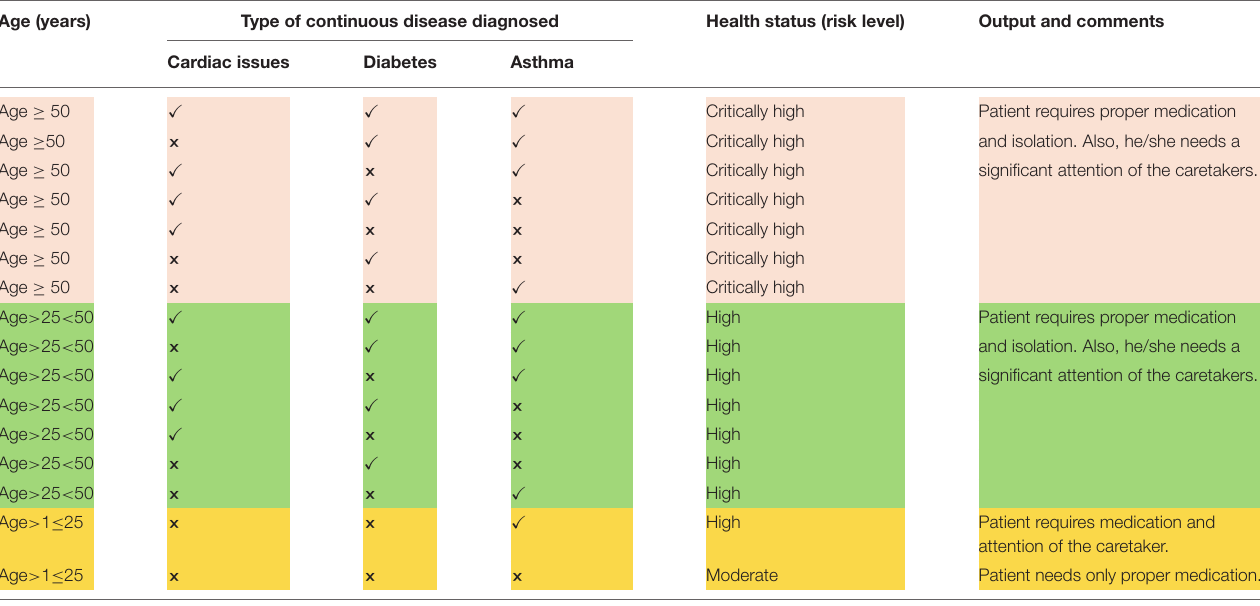
TABLE 3 | Severity-based analysis.